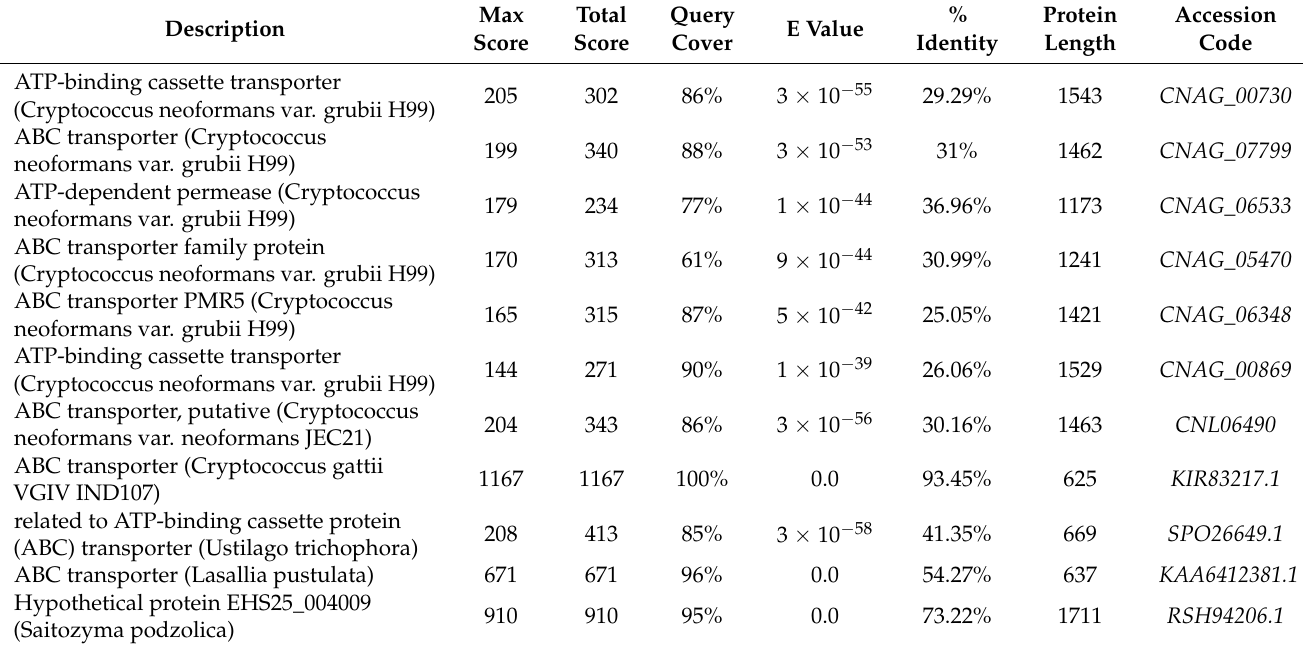
Table 1. Similar Proteins to Afr3 across Different Fungal